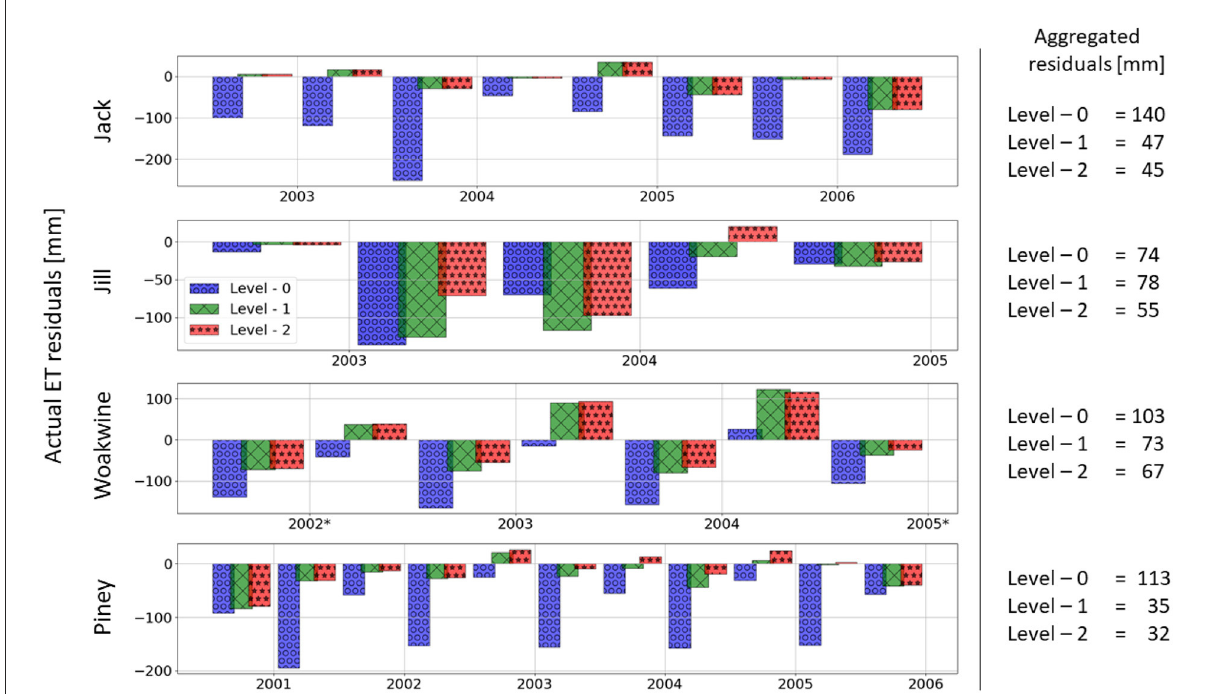
FIGURE5 Residuals of the actual ET (RET) depths calculated as 6-month aggregates, and aggregated RET over the simulation